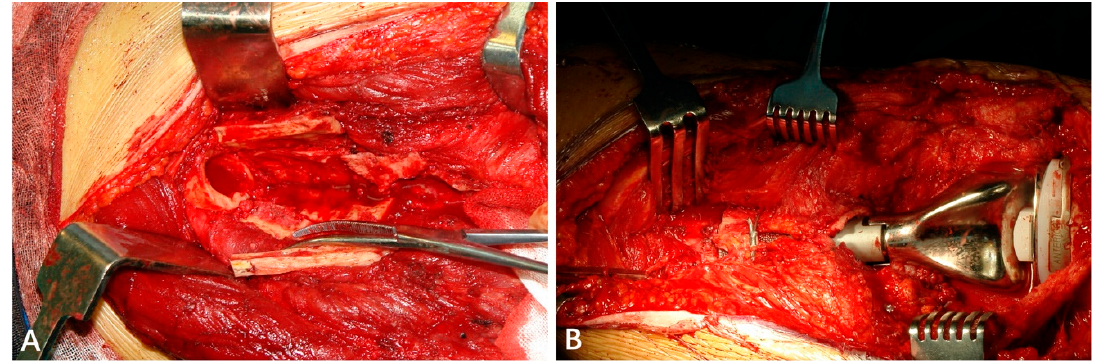
Figure 2. ( A ) In this case, the cortical bone was divided into five parts to facilitate the bone-bridging. The continuity of the cortical bone with the remaining bone was maintained in 4 of them. ( B ) The cortical bone-bridging was fixed to the porous coating section with one wire.